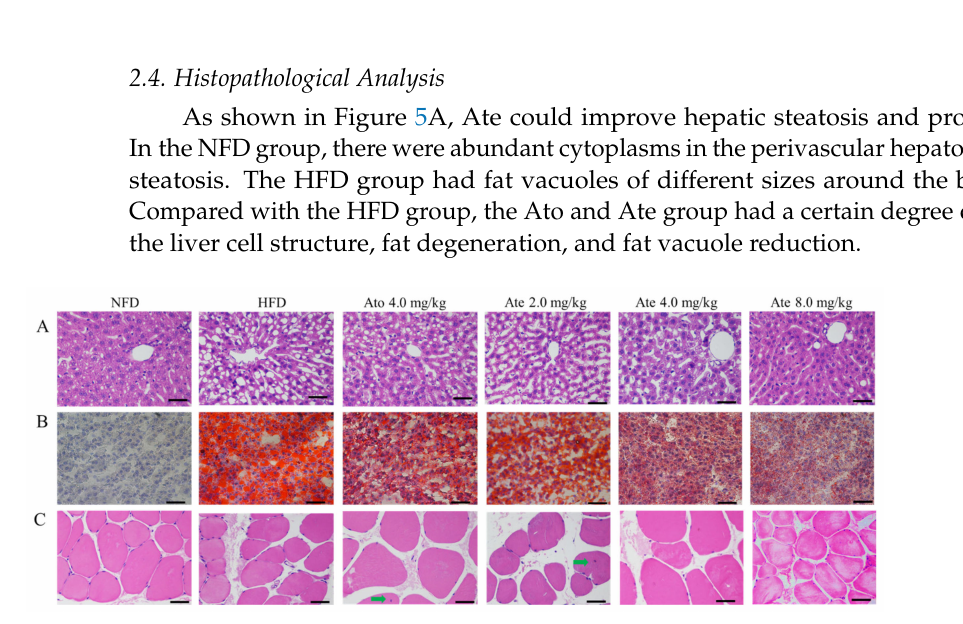
Figure 5. ( A ) HE-staining of rat liver in each group (400 × ): the cytoplasm of muscle cells is purple-red and the nucleus is blue. ( B ) Oil red O-staining of rat livers in each group (400 × ): the triglycerides were stained orange-red and the nucleus were stained blue. ( C ) Comparison of HE-staining in the cross-section of gastrocnemius muscle fibers in each group (400 × ): the cytoplasm of muscle cells is rose-red and the nucleus is blue. The green arrow indicates the inward migration of the